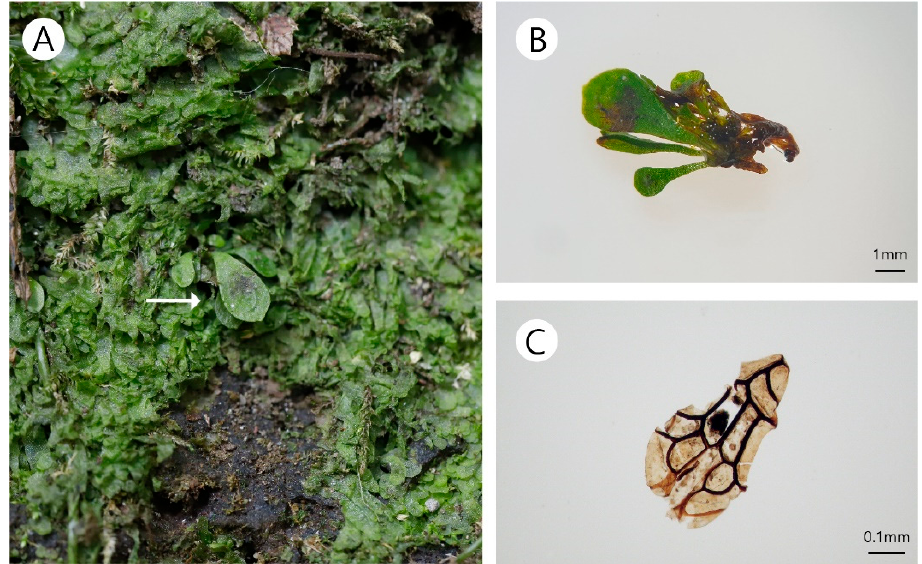
Figure 3. Morphology of the juvenile sporophyte of Antrophyum obovatum . ( A ) Habitat of sporophytes. ( B ) Juvenile sporophyte. ( C ) Scale of rhizome.